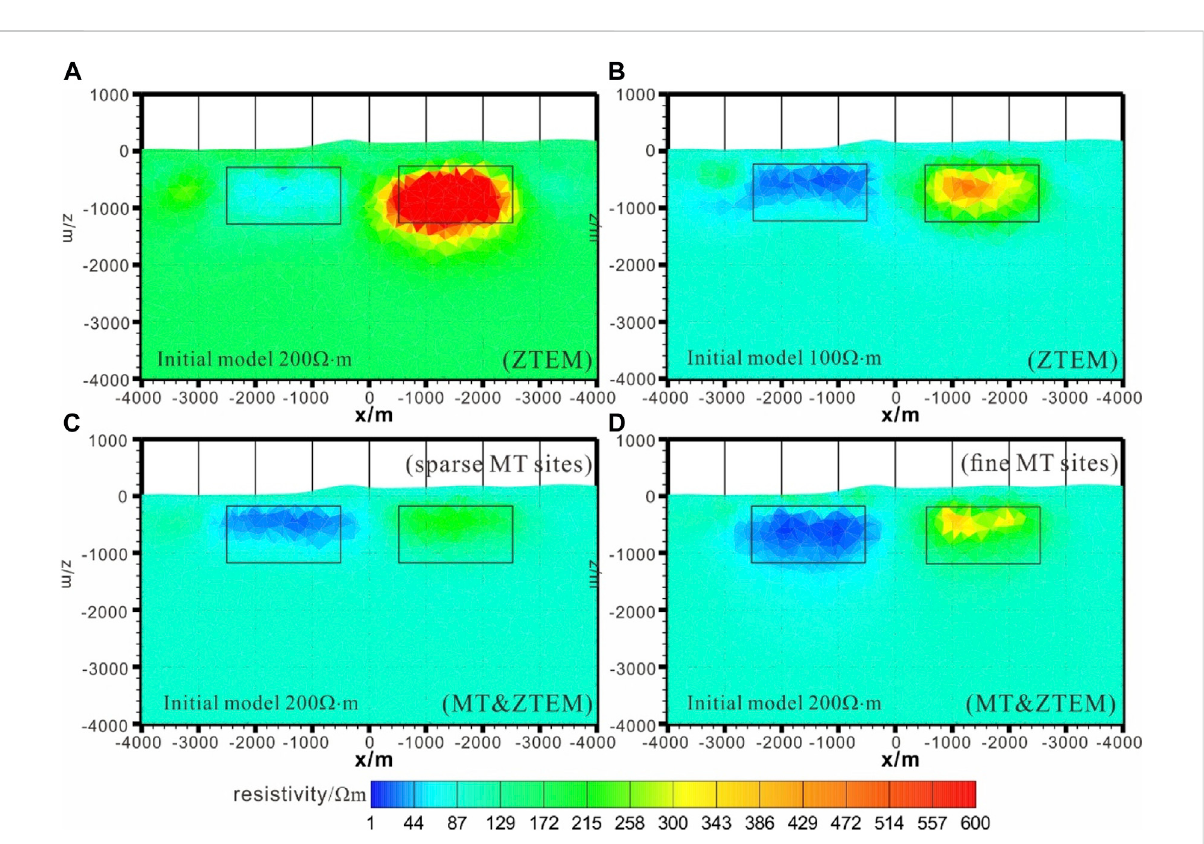
FIGURE 10 Inversion results for the synthetic model at the xz section for y =0 m. (A,B) and (C) are the MT inversion, ZTEMinversion, and joint MT and ZTEM inversion with initial model and a 200 Ω · m half-space, respectively. (D) is the ZTEM inversion with a 100 Ω · m